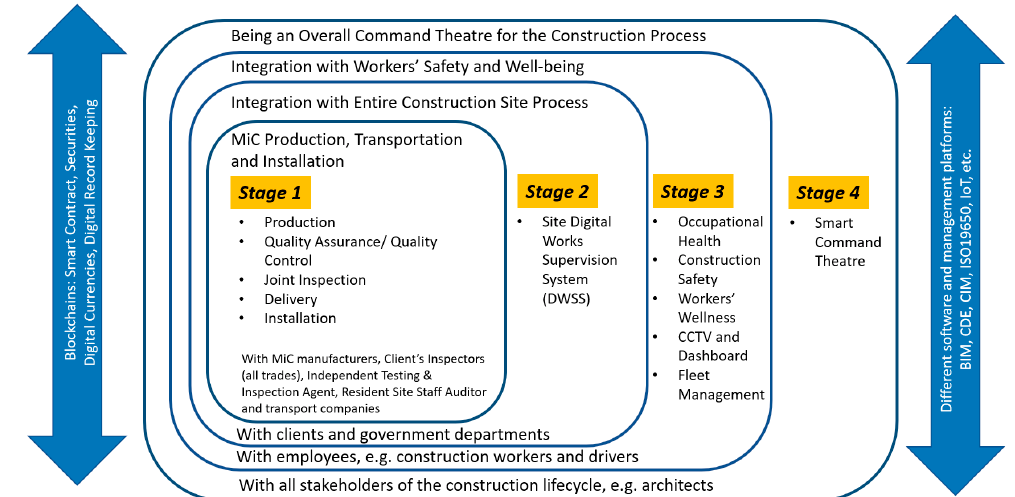
Figure 3. A Conceptual Framework of Smart Construction: The Case of MiC.